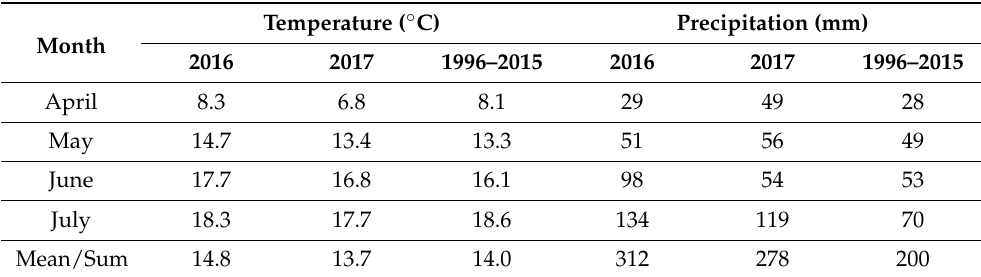
Table 1. Monthly temperature and precipitation at Mochełek, Poland.